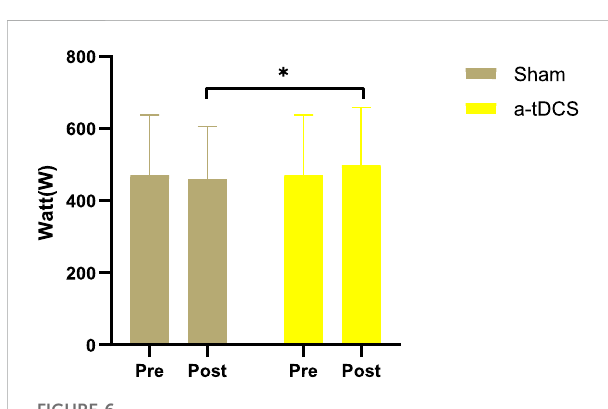
FIGURE 6 Right-arm pull-down explosive force. The white bars represent real stimulation compared to pre-stimulation, while the gray bars representshamstimulationcomparedtopre-stimulation. “ Pre ” means before stimulation, and “ post ” means after stimulation. Note: * means p <